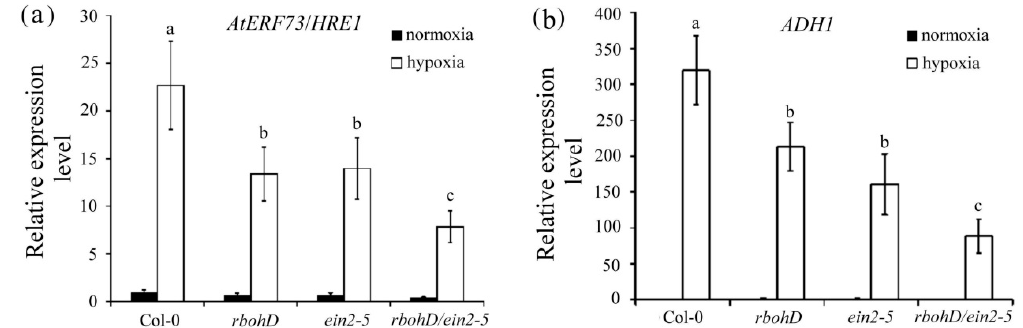
Figure 7. Transcript levels of hypoxia-inducible genes encoding AtERF73 / HRE1 and ADH1 in Figure 7 . Transcript levels of hypoxia ‐ inducible genes encoding AtERF73/HRE1 and ADH1 in rbohD / ein2-5 lines after hypoxia treatment. Total RNAs were isolated from roots of 14-day-old Col-0, rbohD / ein2 ‐ 5 lines after hypoxia treatment. Total RNAs were isolated from roots of 14 ‐ day ‐ old Col ‐ 0, rbohD , ein2-5 , and rbohD / ein2-5 seedlings after 3 h of hypoxia treatment. Quantitative RT-PCR analyses rbohD , ein2 ‐ 5 , and rbohD / ein2 ‐ 5 seedlings after 3 h of hypoxia treatment. Quantitative RT ‐ PCR of transcript levels of AtERF73 / HRE1 ( a ) and ADH1 ( b ) genes. Values are means ± SD from three analyses of transcript levels of AtERF73/HRE1 ( a ) and ADH1 ( b ) genes. Values are means ± SD from biologically independent experiments ( n = 3). Values with di ff erent letters are significantly di ff erent at three biologically independent experiments ( n = 3). Values with different letters are significantly p < 0.05, according to a post-hoc LSD different at P < 0.05, according to a post ‐ hoc LSD test.